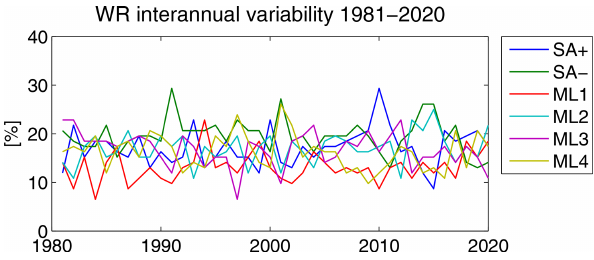
Figure 12. ERA5 WR frequency 1981–2020: interannual variabil-